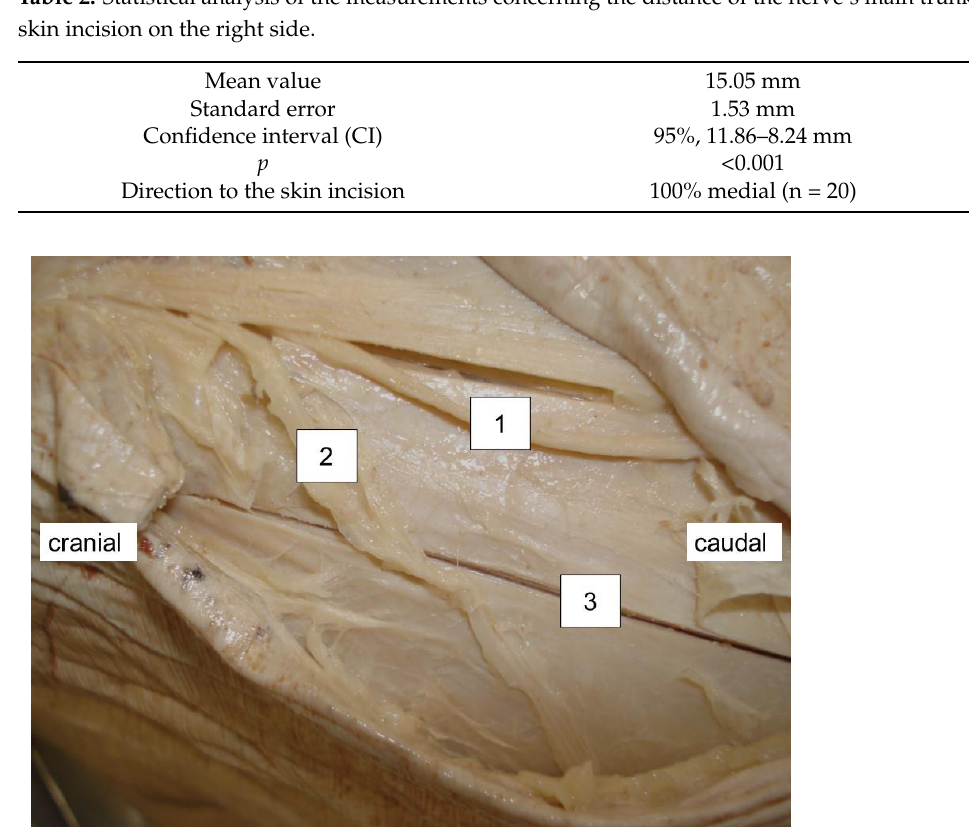
Figure 5. Situation at the branching of the main trunk and the gluteal branch in. relation to the skin incision. 1 = main trunk, 2 = gluteal branch, 3 = skin incision. incision. 1 = main trunk, 2 = gluteal branch, 3 = skin